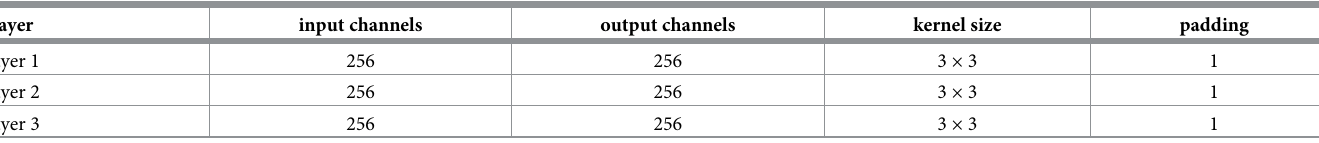
Table 2. Parameters used for three convolution